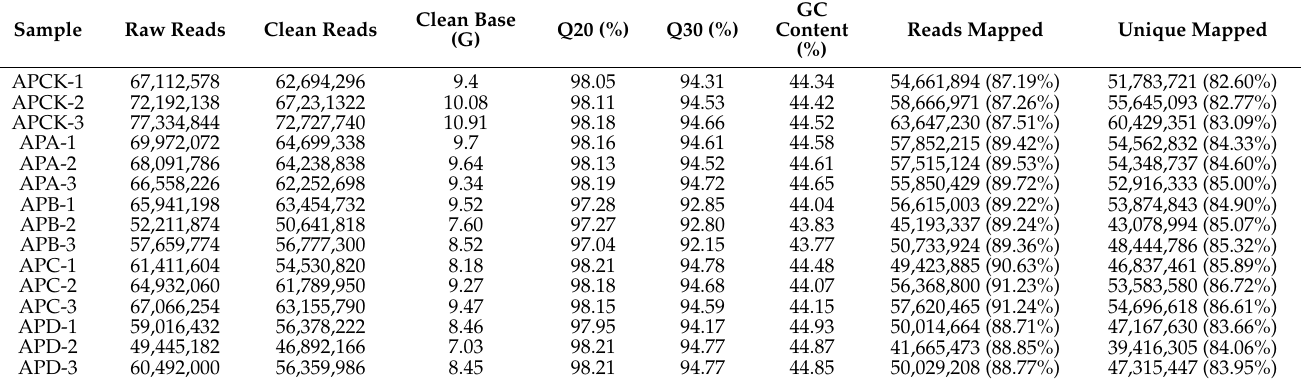
Table 1 . Summary of the RNA-seq data collected from A. pseudosieboldianum .